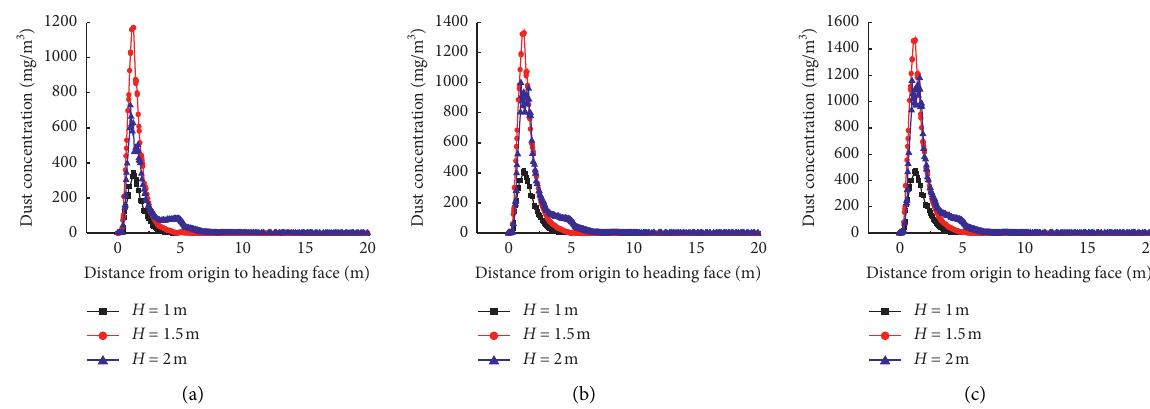
Figure 5: Effect of dust concentration in working space: (a) v � 150m 3 /min, (b) v � 400m 3 /min, and (c) v � 500m 3